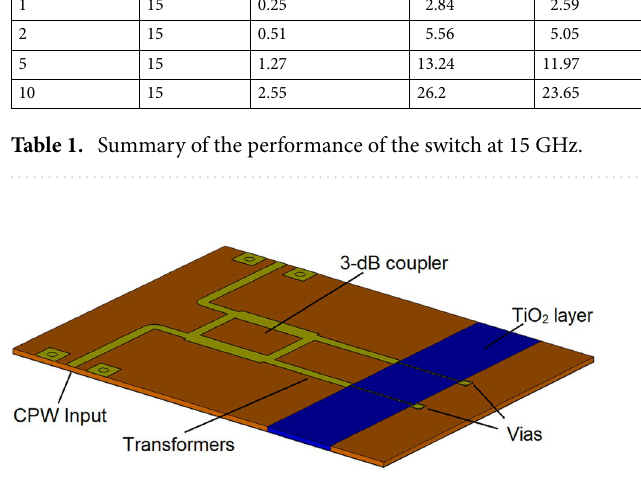
Figure 21. Reflective-type variable attenuator (RTVA) based on TiO 2 .